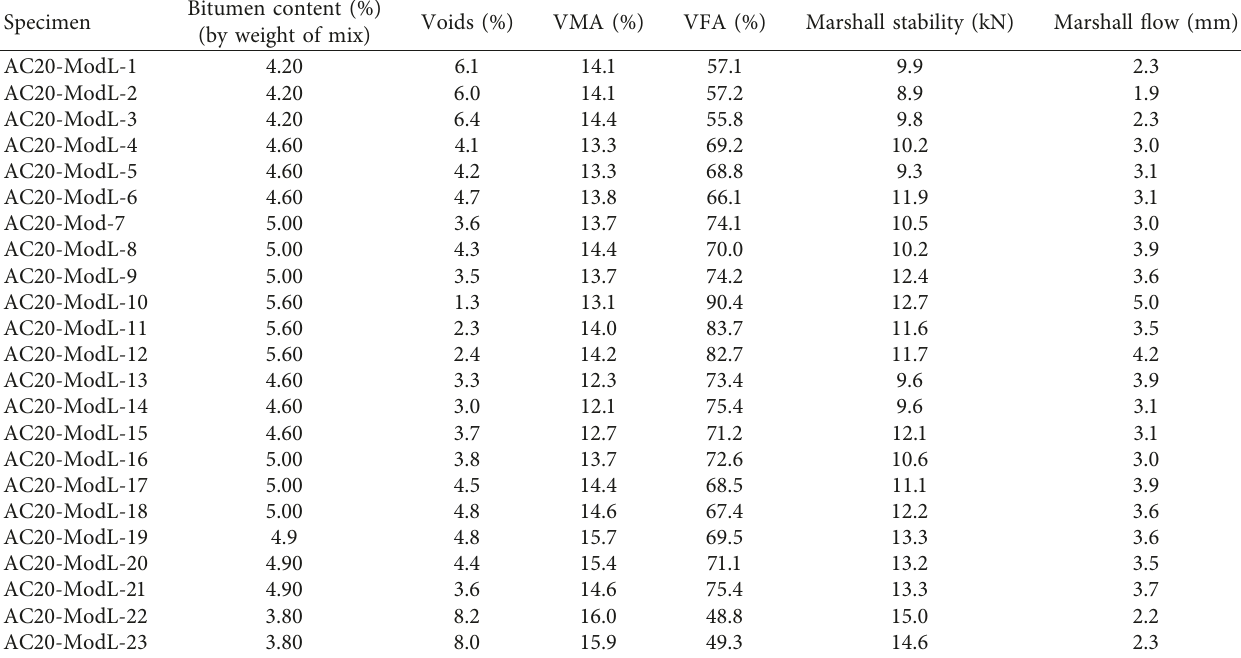
Table 4: Properties of AC20-ModL